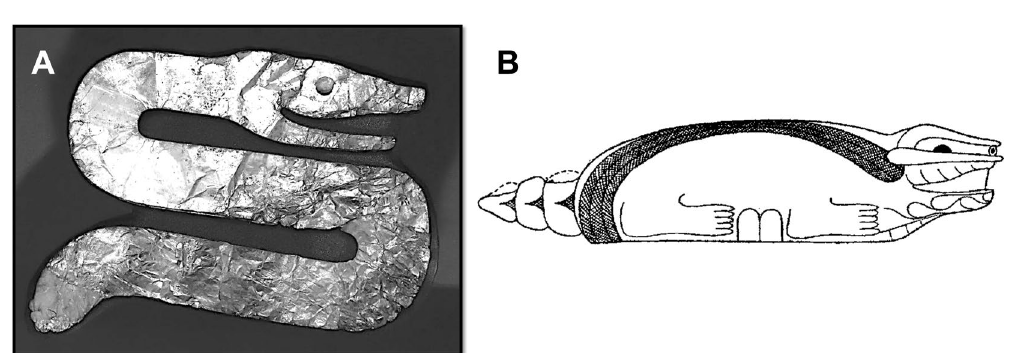
Figure 2. Sky Panthers, also known as horned serpents, excavated in direct association with a pallasite from a Hopewell archaeological feature known as “altar 4” at the Turner site, located near the epicenter of the airburst in Hamilton County, Ohio, USA. ( A ) Hopewell Sky Panther or horned serpent carved from mica; ( B ) Hopewell Sky Panther or horned serpent manufactured from ground-stone. Kenneth Barnett Tankersley created the figure using Microsoft PowerPoint for Mac Version 16.41 (www. micro soft.